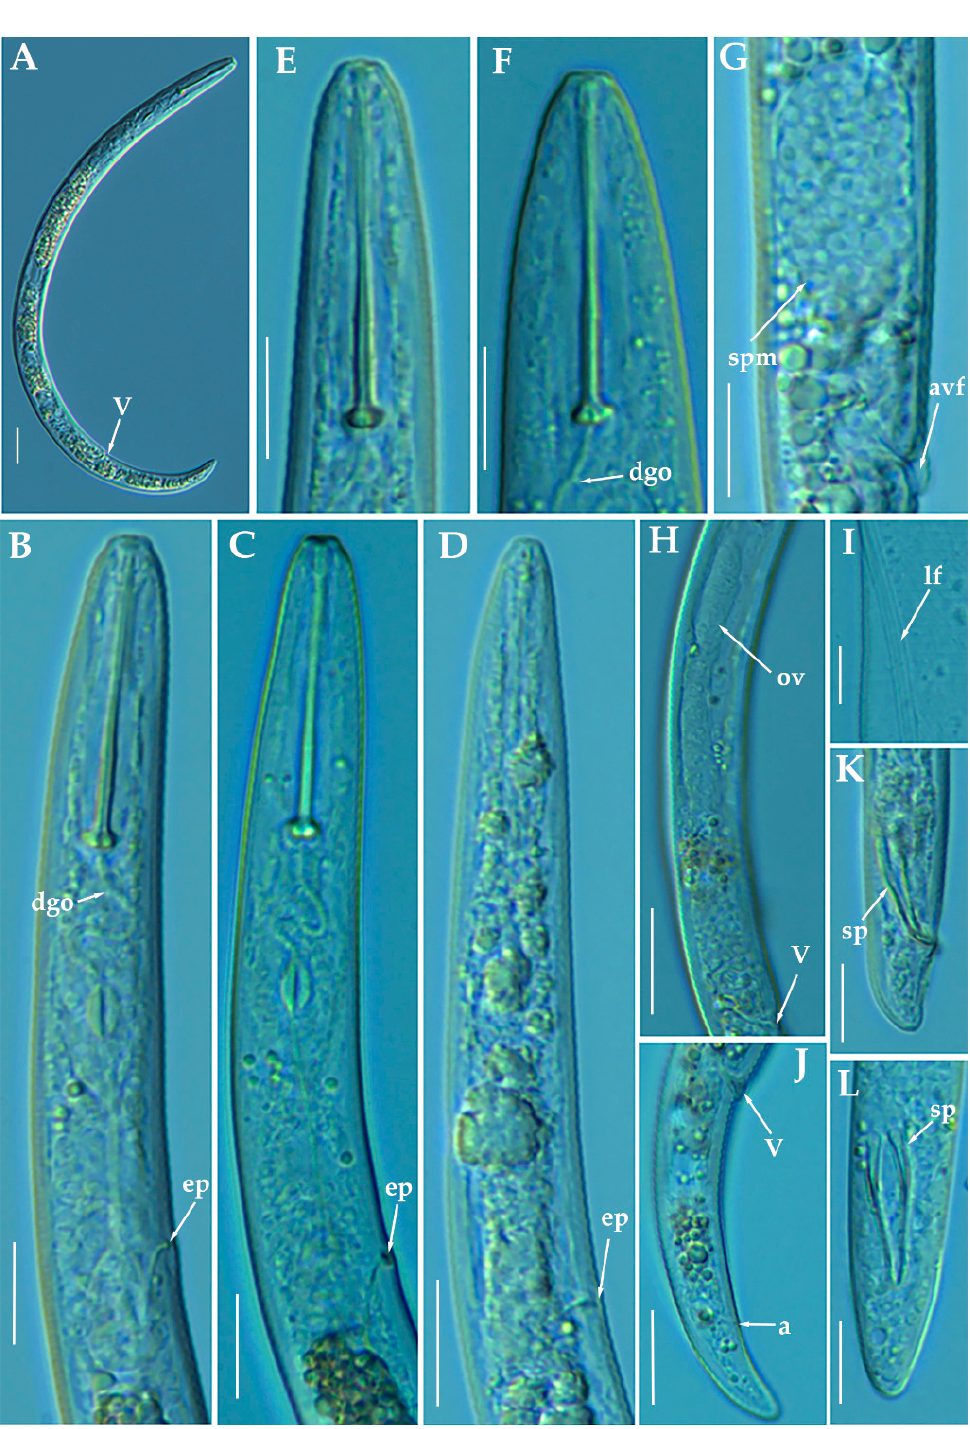
Figure 7. Light photomicrographs of female of Paratylenchus pedrami sp. nov. ( A ): Entire female with vulva arrowed; ( B , C ): Female pharyngeal region; ( D ): Male pharyngeal region; ( E , F ): Female lip region; ( G ): Vulval region showing spermatheca (arrowed); ( H ): Female posterior region showing complete genital branch; ( I ): Detail of lateral field at mid-body (arrowed); ( J ): Female posterior region with vulva and anus arrowed; K, L: Male posterior region with spicules (arrowed). Scale bars ( A , H , J = 20 μ m; B – G , I , K , L = 10 μ m). (Abbreviations: a= anus; avf= advulval flap; dgo= pharyn- geal dorsal gland orifice; ep = excretory pore; lf = lateral field; ov= ovary; spm= spermatheca; V= vulva).